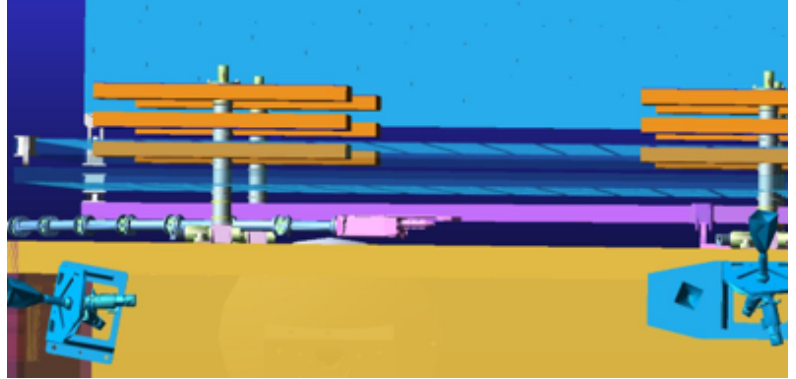
Figure 22. Slit crossing schematic diagram.